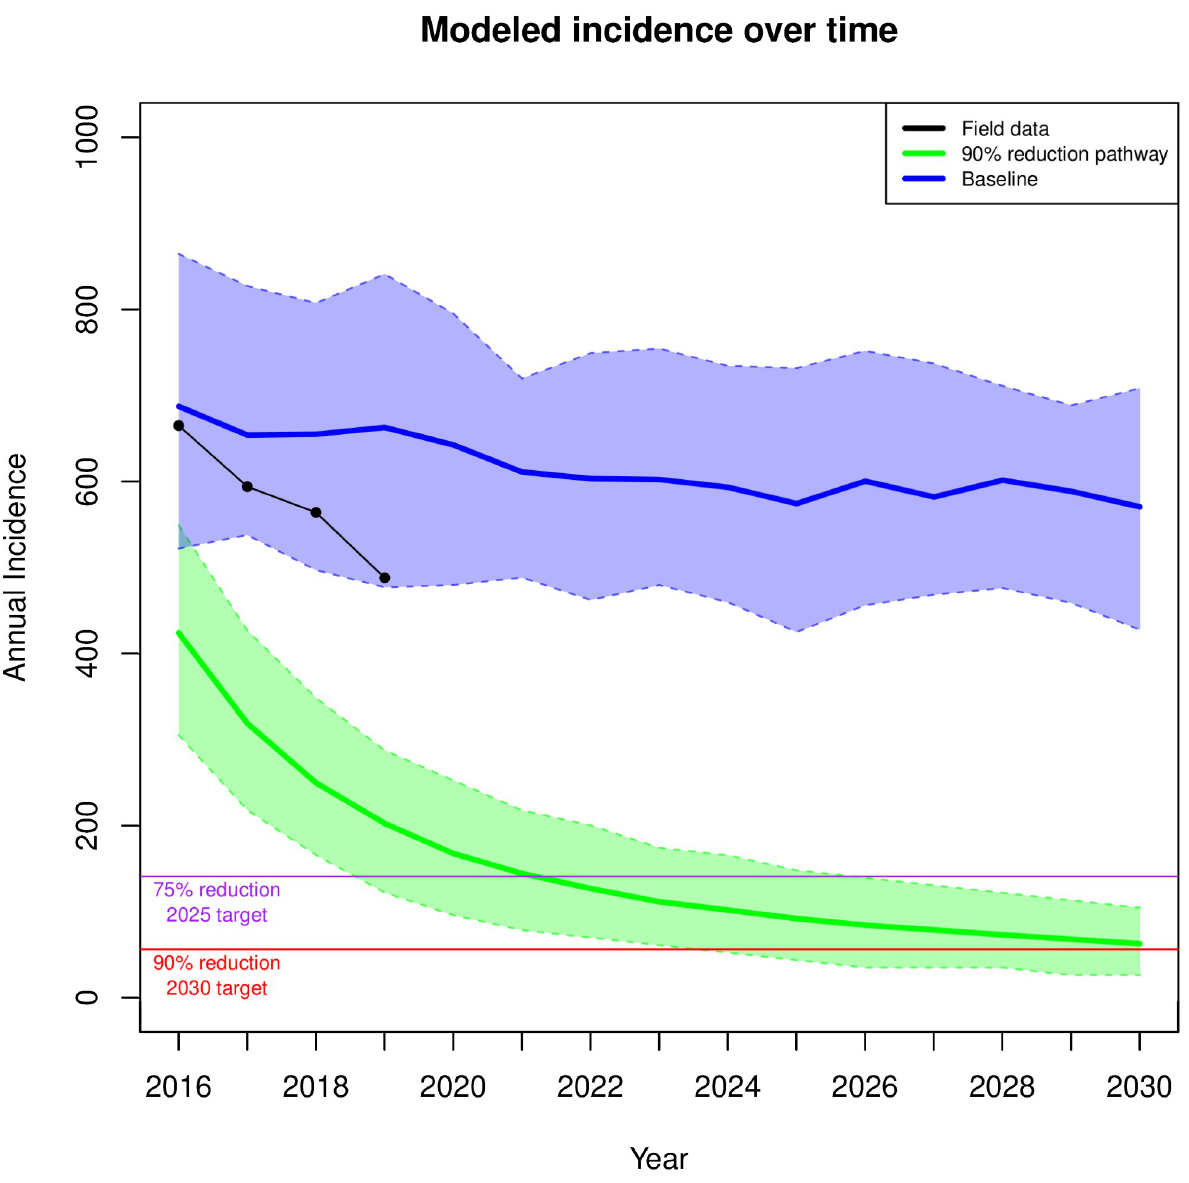
Fig 6. Projected incidence over time: Projected number of incidence cases over time for the baseline model (blue) and the optimal 90% reduction scenario (green). Solid line shows the mean projection; colored surface, the 80% Prediction Interval. The black line shows observed levels based on the most recent CDPH surveillance